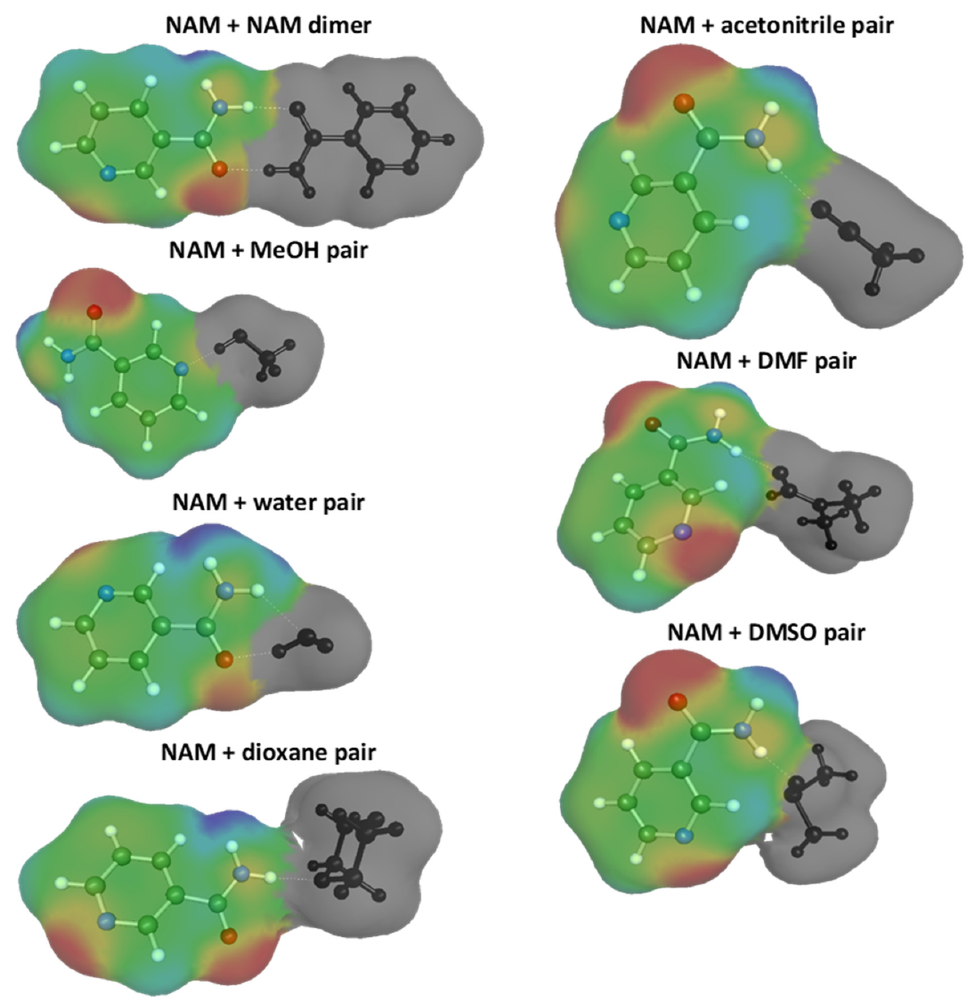
Figure 6. Graphical representation of pseudo-conformers included in the COSMO-RS-DARE computations of nicotina- mide interactions with itself and each of the solvent molecules in the studied systems.